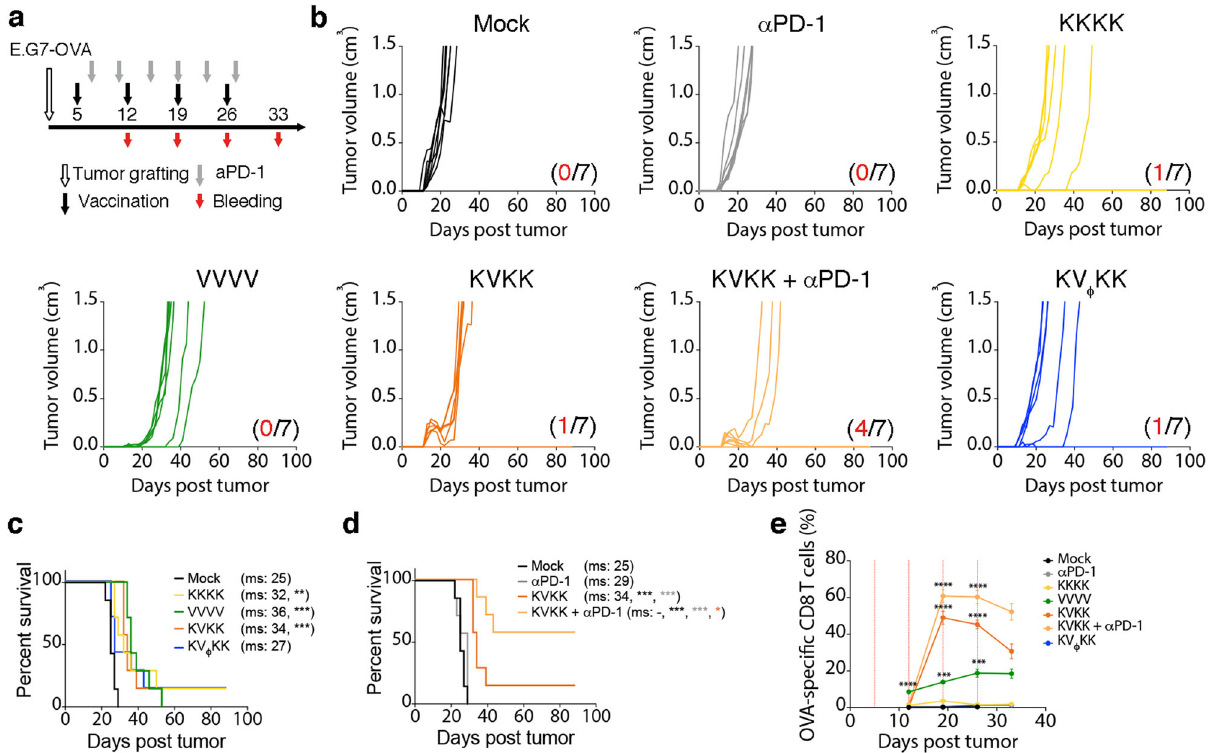
Fig. 5 Therapeutic effect of heterologous vaccine in syngeneic tumor model expressing ovalbumin. a – e C57BL/6J mice were injected s.c. with E.G7- OVA cells and vaccinated with KISIMA-OVA (K) s.c. or VSV-GP-OVA (V) i.v. on days indicated in schematic ( a ). 200 µ g α PD-1 antibody was given i.v. twice weekly and blood was drawn for tetramer analysis as shown ( n = 7). b Tumor growth and ( c , d ) survival is depicted with red numbers indicating long- term remissions within a group. Pairwise Log-rank test was performed (* p < 0.05; ** p < 0.01; *** p < 0.001). e Frequency (mean± SEM) of OVA-speci fi c CD8 + T cells in circulation is shown . One-way ANOVA with Tukey ’ s multiple comparison was performed and signi fi cance displayed only for each vaccinated group vs. mock (* p < 0.05; ** p < 0.01; *** p < 0.001; **** p < 0.0001). The experiments ( b – d ) were repeated once with i.m. application of VSV- GP-OVA. Study ( e ) was performed once. Source data and p-values are provided in the Source Data